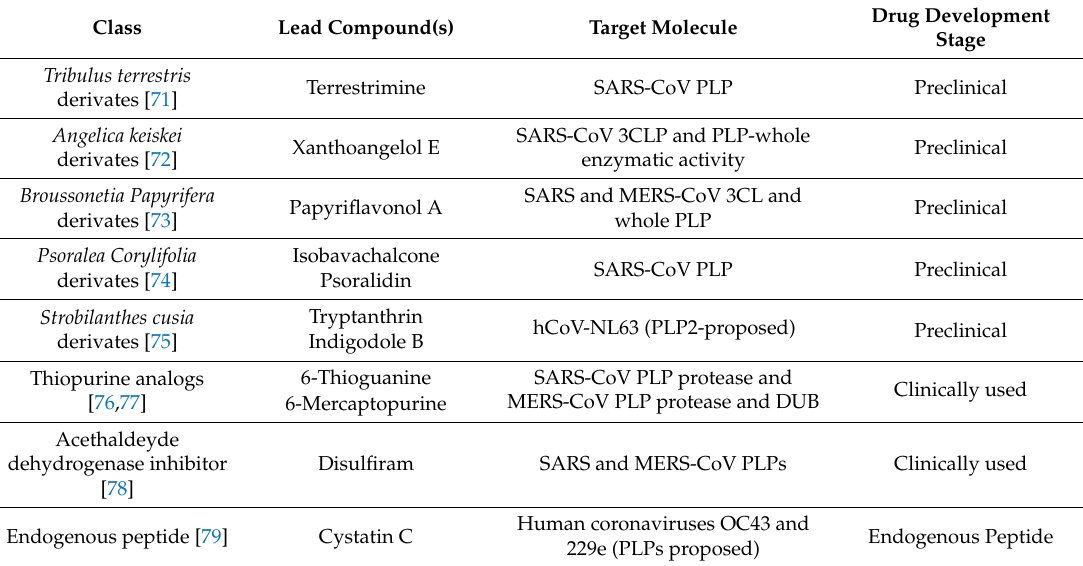
Table 1. In the table below are listed the main PLP inhibitors reported in this